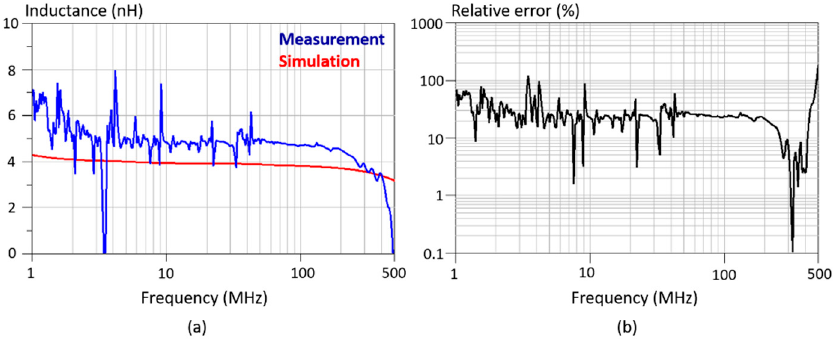
Figure 22. Vertical commutation loop inductance extraction: ( a ) measurement vs. simulation; ( b ) relative error.